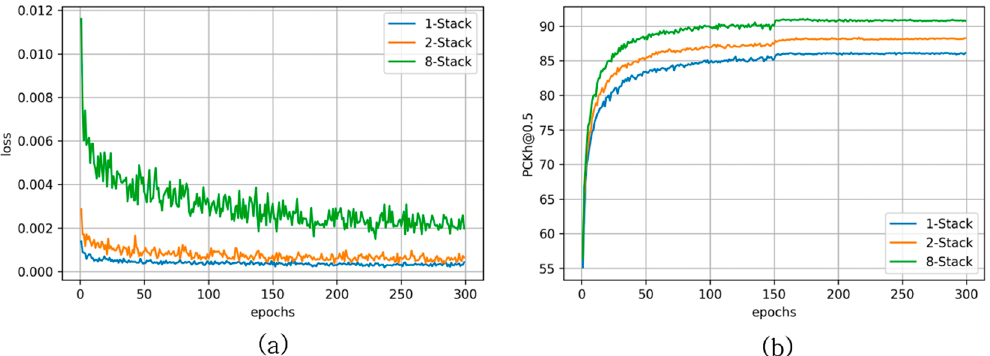
Figure 6. ( a ) Loss during training and ( b ) PCKh@0.5 on the MPII validation set.